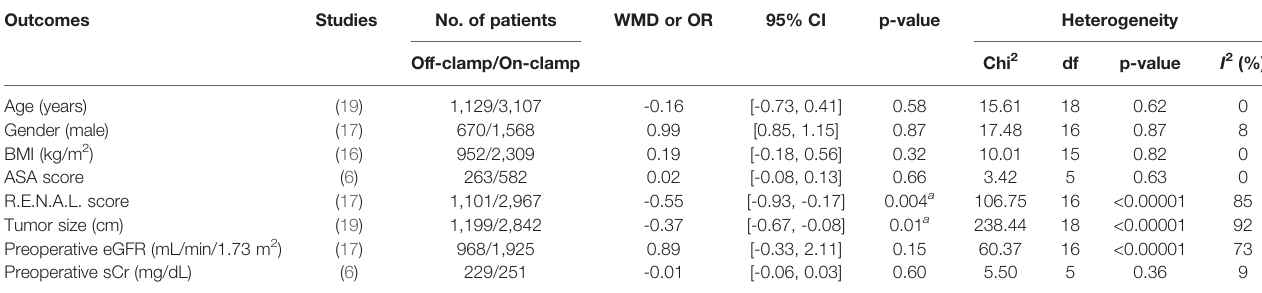
TABLE 2 | Demographics and clinical characteristics of included studies.